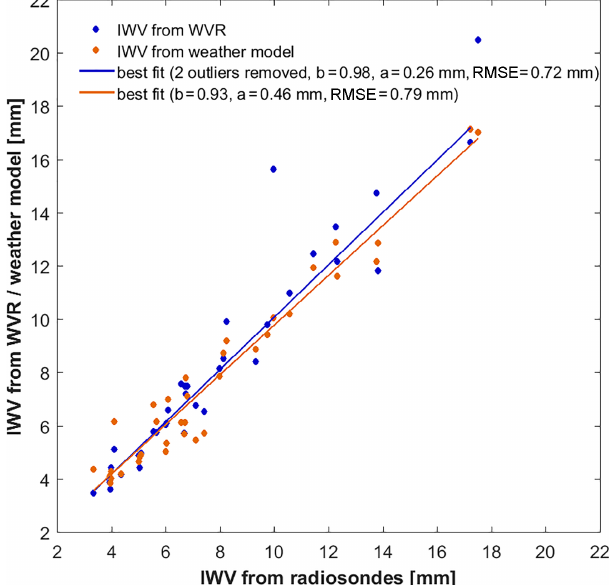
Figure 8. Linear regression between integrated water vapor (IWV) content derived from radiosonde data and that from water vapor ra- diometer (WVR) and weather model data. The two outliers were removed in the